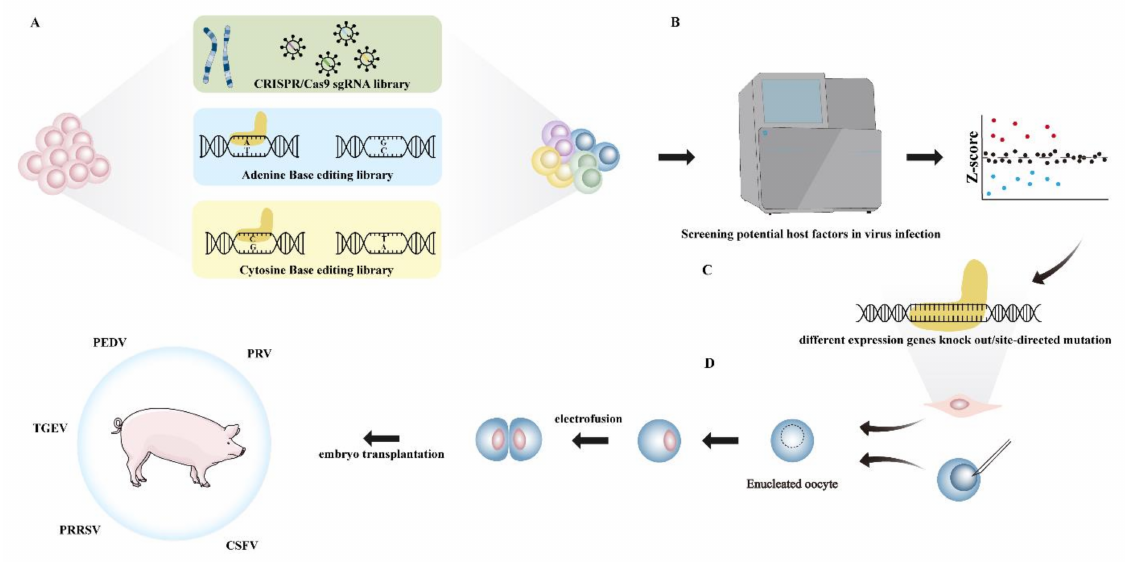
Figure 1. Possible method of producing virus-resistant pigs in the future. ( A ) First, genome-wide knockout cells were constructed from lentivirus-packaged CRISPR/Cas9 library or ABE/CBE library. nology after several rounds of viral infection. ( C ) Fetal fibroblast cells over-expressing or without oocytes, and cloned pigs were prepared by embryo